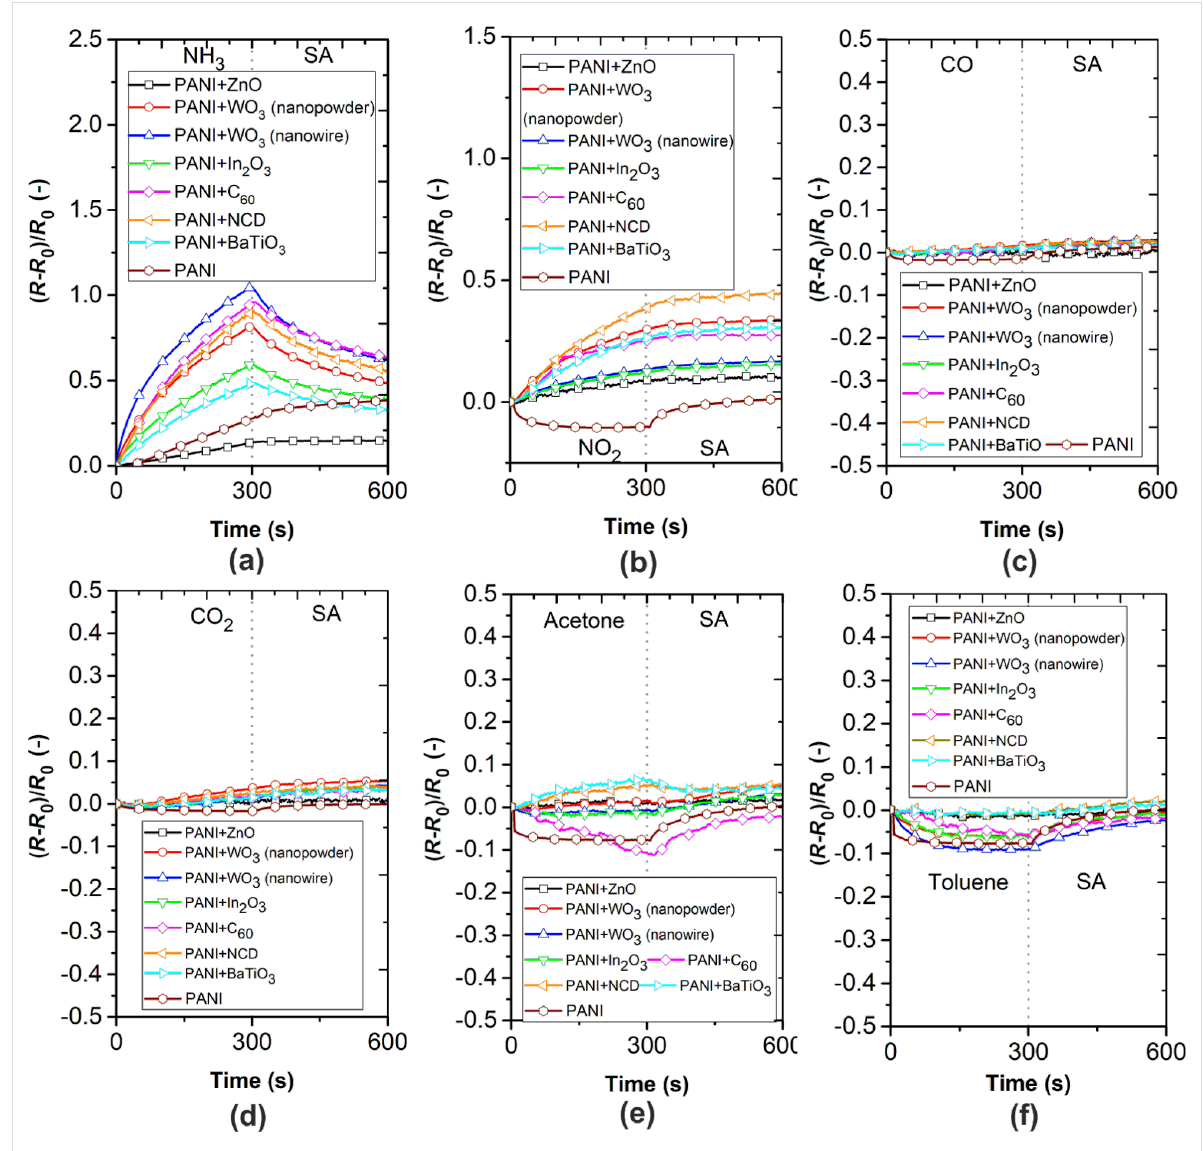
Figure 6: Gas characterization of active layers towards (a) 25 ppm of NH 3 , (b) 25 ppm of NO 2 , (c) 25 ppm of CO, (d) 250 ppm of CO 2 , (e) 6000 ppm of acetone, and (f) 500 ppm of toluene at room